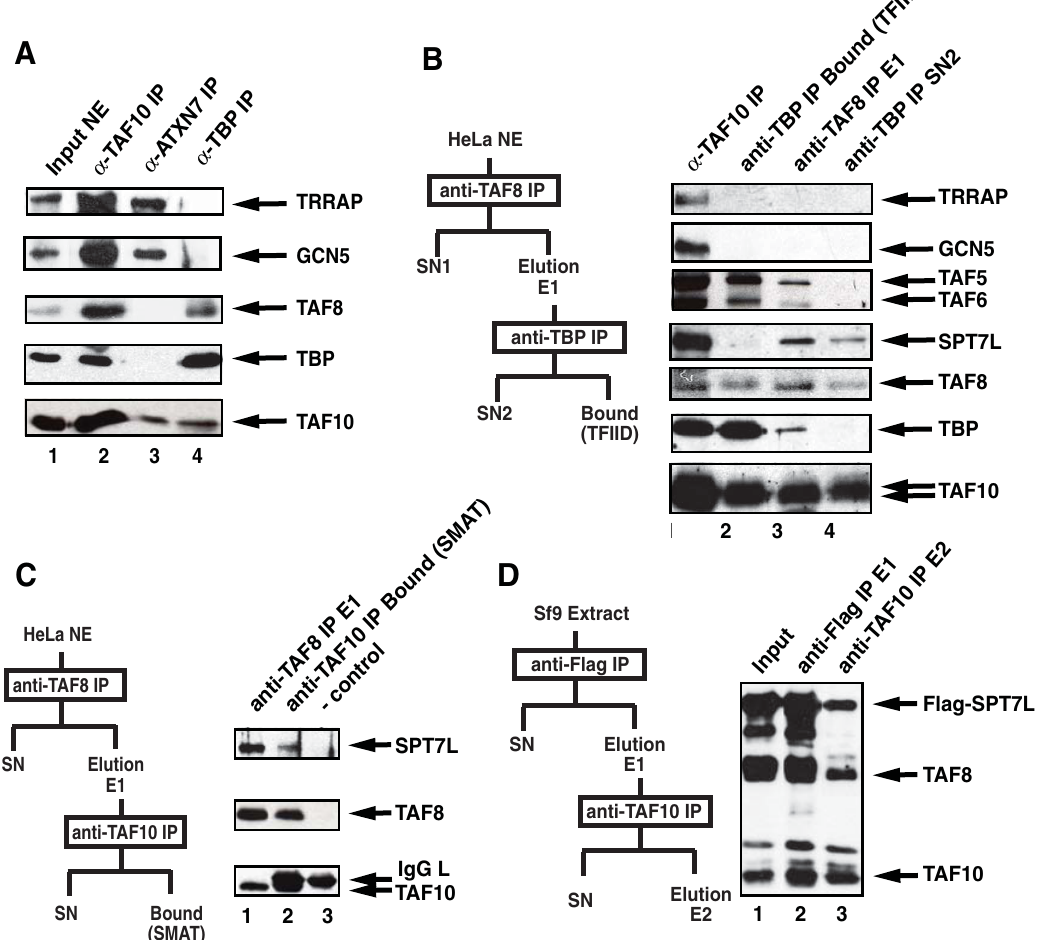
Figure 5. TAF8 is not a subunit of TFTC/STAGA type complexes, but is present in TFIID and a novel TAF8-, TAF10- and SPT7L-containing complex that can also be formed invitro. (A) The indicated transcription factors were immunoprecipitated using specific mAbs (1H8 anti-TAF10; 2A10 anti- ATXN7 and 2C1 anti-TBP) from HeLa cell nuclear extract (NE) and eluted by an excess of peptides against which the mAbs were raised. Eluted protein complexes were separated by SDS-PAGE and analysed by western blot with the indicated antibodies. (B) TAF8-containing protein complexes were purified from HeLa NE according to the scheme shown on the left of the panel. The eluate obtained after the first anti-TAF8 IP using the 2TAU 2B8 mAb (anti-TAF8 IP E1; lane 3) and the supernatant obtained after the TAF8-containing complexes were depleted in TFIID using the anti-TBP 2C1 mAb (SN2; lane 4). They were separated along with complexes obtained after an anti-TAF10 IP (TFIID and TFTC together; lane 1) or with a highly purified TFIID fraction (lane 2) on SDS-PAGE and analysed with the indicated antibodies by western blot. (C) TAF8 containing complexes were purified from HeLa NE according to the scheme on the left of the panel. TAF10-containing complexes were re-precipitated from the eluate obtained after the first anti-TAF8 IP (E1, lane 1) extensively washed and loaded after boiling the beads (lane 2) with loading buffer on a SDS-PAGE. The migration of the antibody alone (-control) is shown in lane 3. Proteins were analyzed with the indicated antibodies by western blot. (D) TAF8, TAF10 and Flag-SPT7L were co-expressed in Sf9 cells. WCEs were made and proteins were subjected to two successive immunoprecipitations and elutions by peptide competition according to the schemes shown on the left of the panel. Input and eluted protein complexes were separated by SDS-PAGE and analysed with the indicated antibodies by western blot.